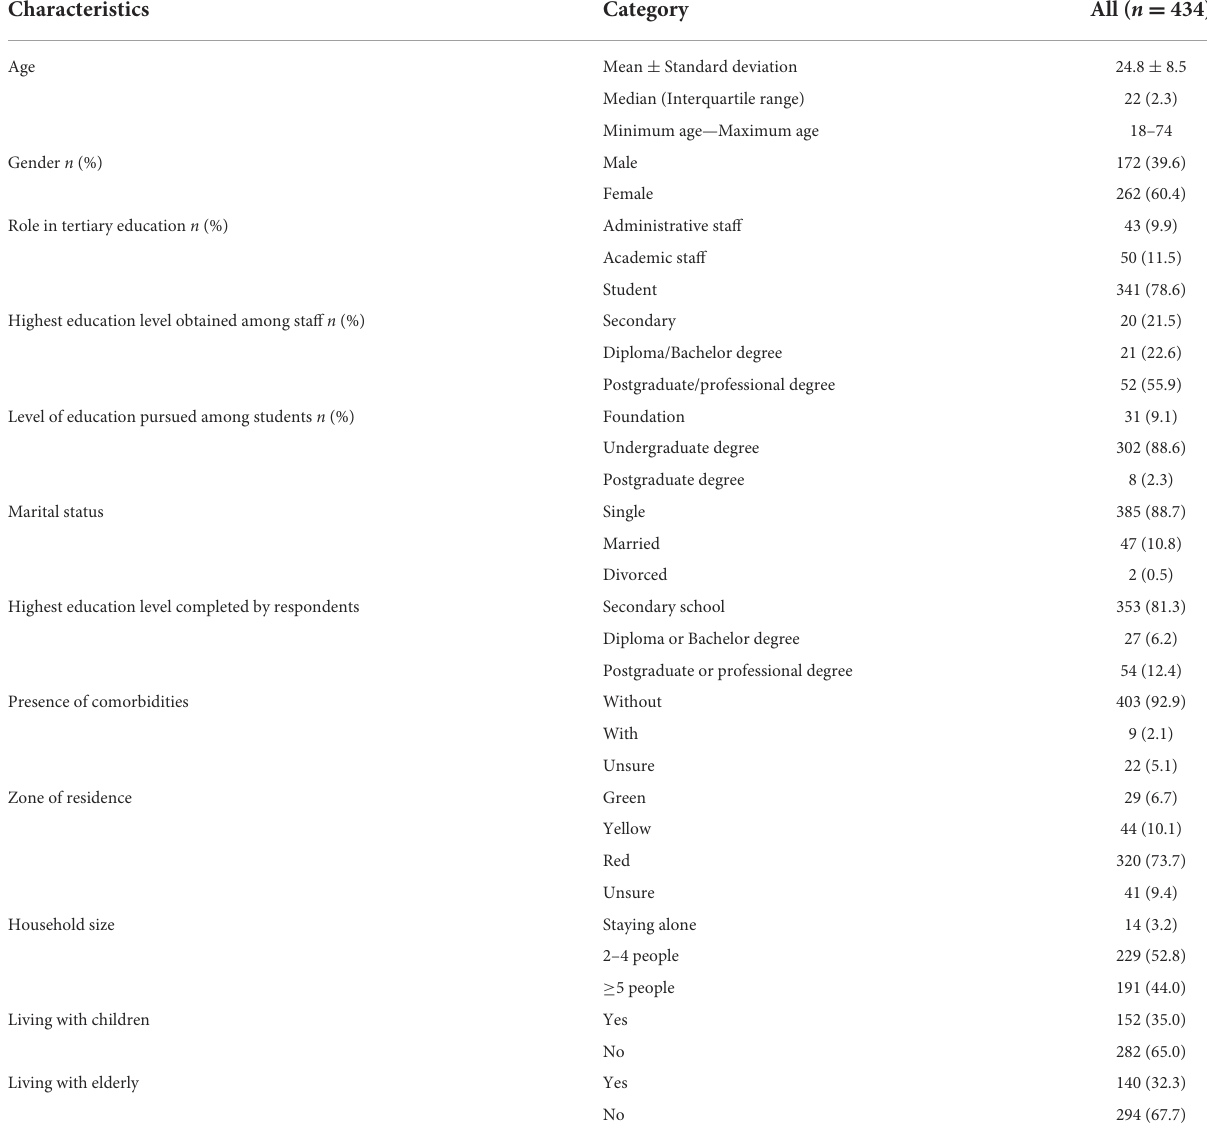
TABLE 1 Characteristics of